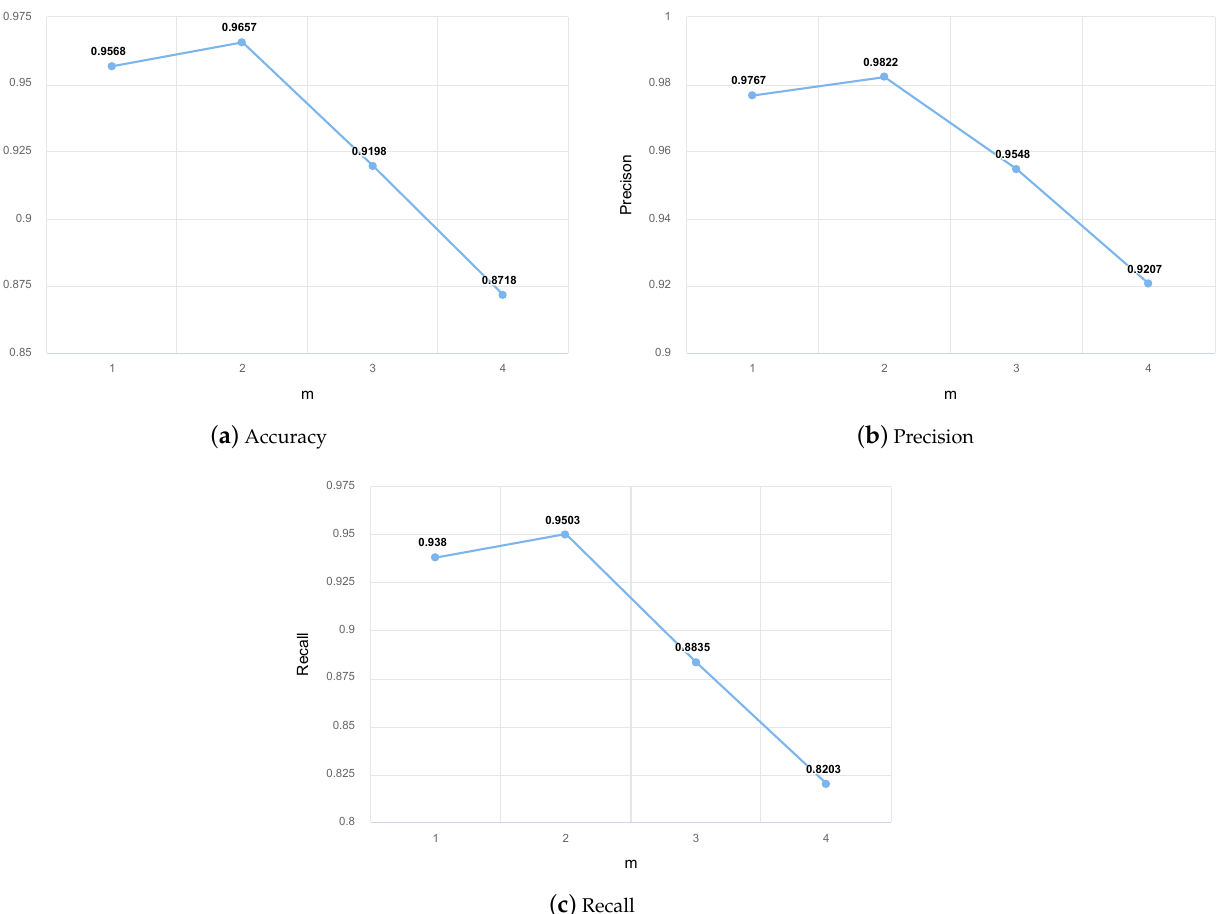
Figure 8. Test results obtained with different m values on the S.cerevisiae core dataset. Where ( a – c ) are the Accuracy, Precision, and Recall with different m values,